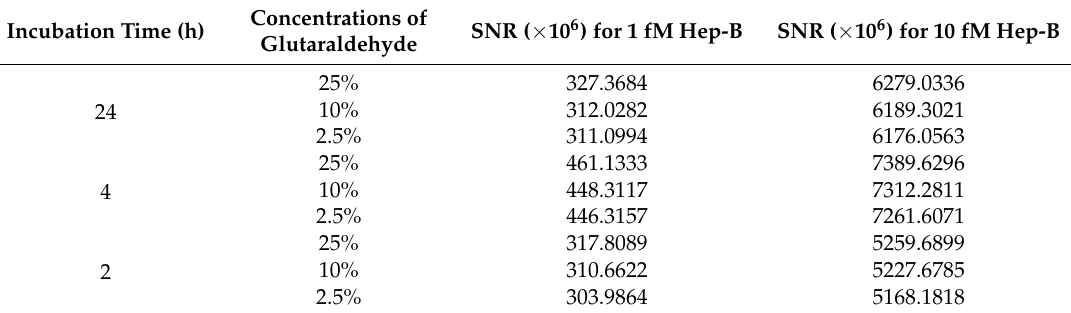
Figure 7. S ( f )/ I DS 2 for 1 fM Hep-B corresponding to ( a ) different times with 25% glutaraldehyde; ( b ) different concentrations after 24 h. Table 1. SNR estimation for 1 fM and 10 fM virus concentrations.